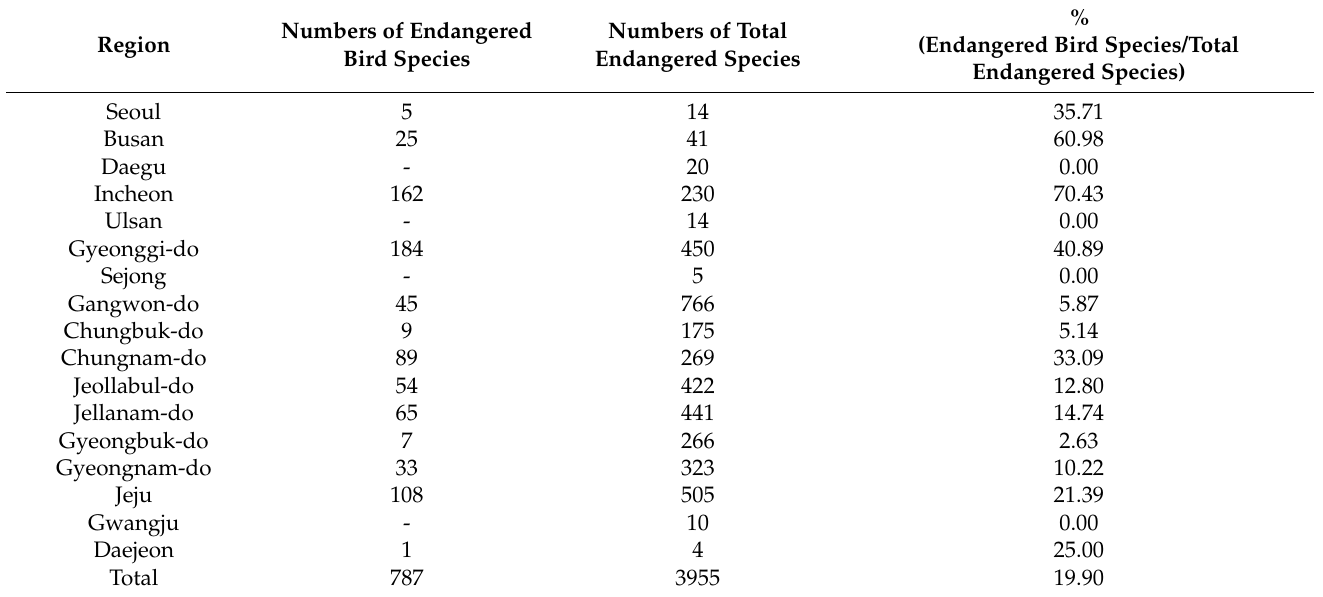
Table 2. Comparison of the numbers of endangered species and endangered birds in Korea (Ministry of Environment